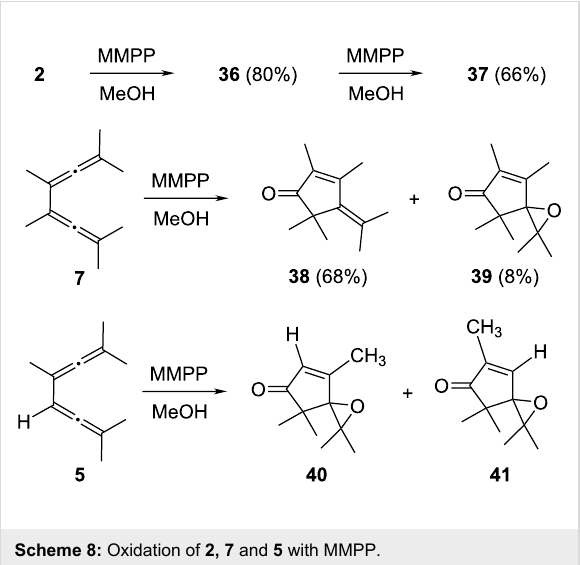
Scheme 8: Oxidation of 2, 7 and 5 with